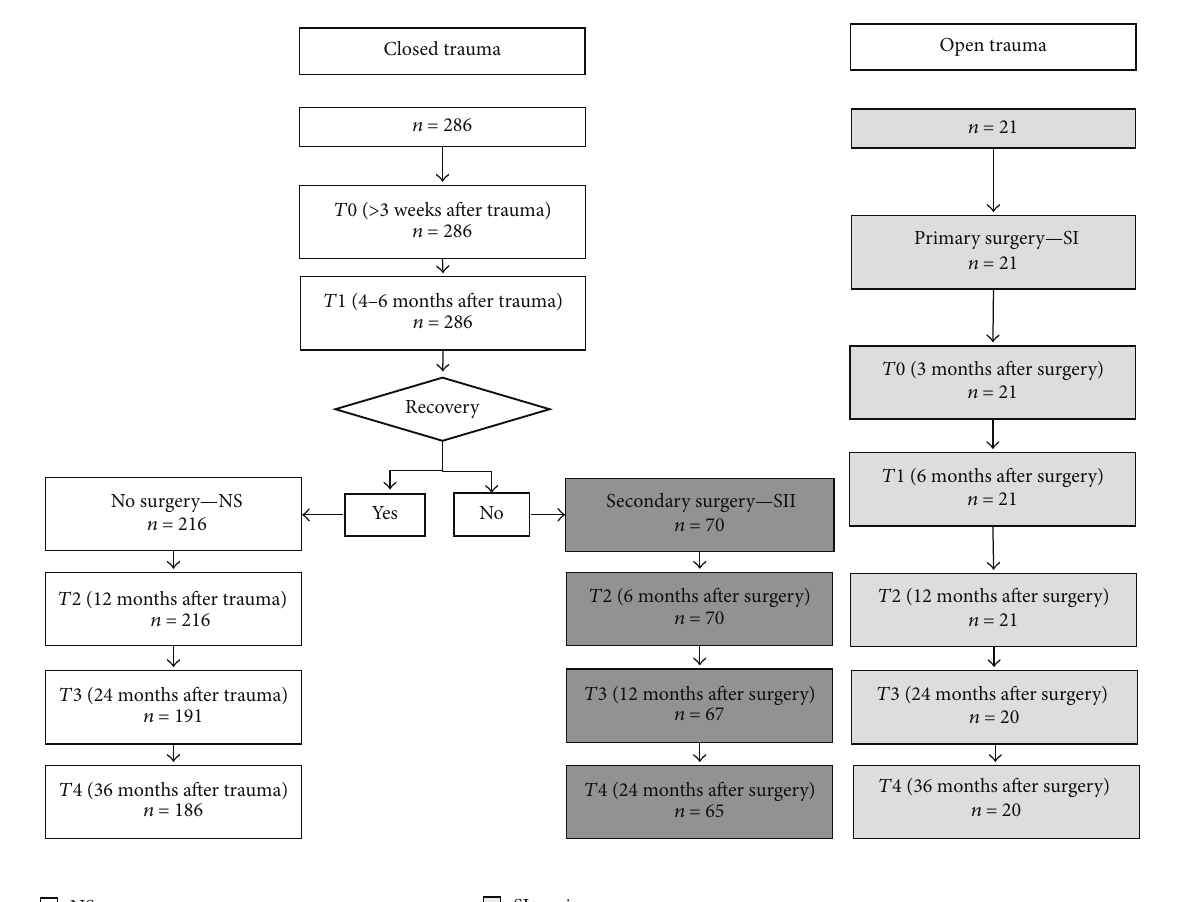
Figure 1: Study flowchart: clinical and neurophysiological